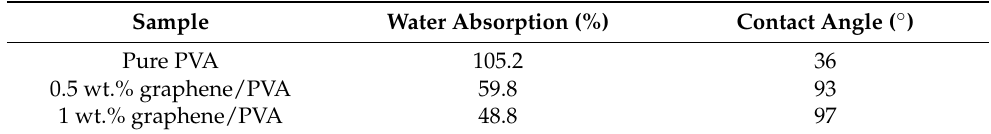
Table 5. Water absorption and contact angles of films with various graphene loadings [49]. (Adapted with permission from ref. [49]. Copyright 2011 John Wiley and